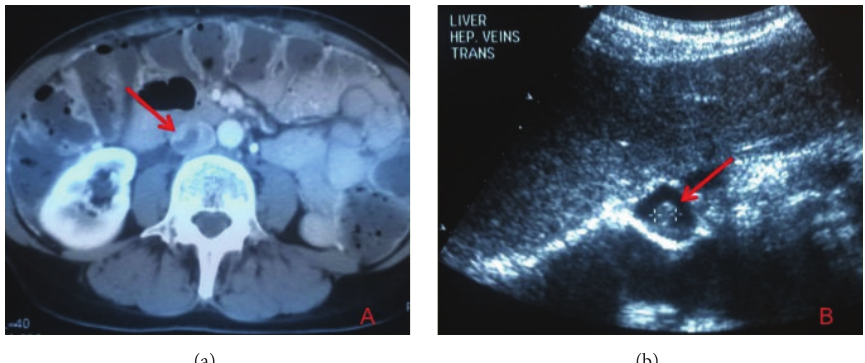
Figure 1: (a) Hypodense filling defect in the IVC on CT and (b) free-floating echodensity at the level of the hepatic veins, both consistent with intracaval